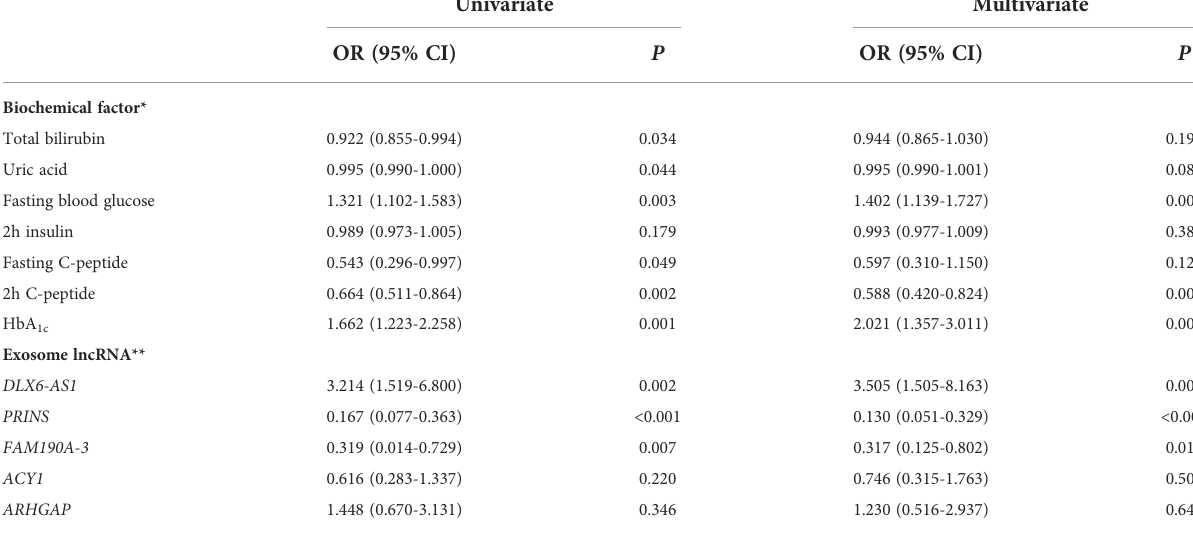
TABLE 3 Univariate and multivariate logistic regression analysis of the association between DR and biochemical factors and exosome lncRNA. Univariate Multivariate